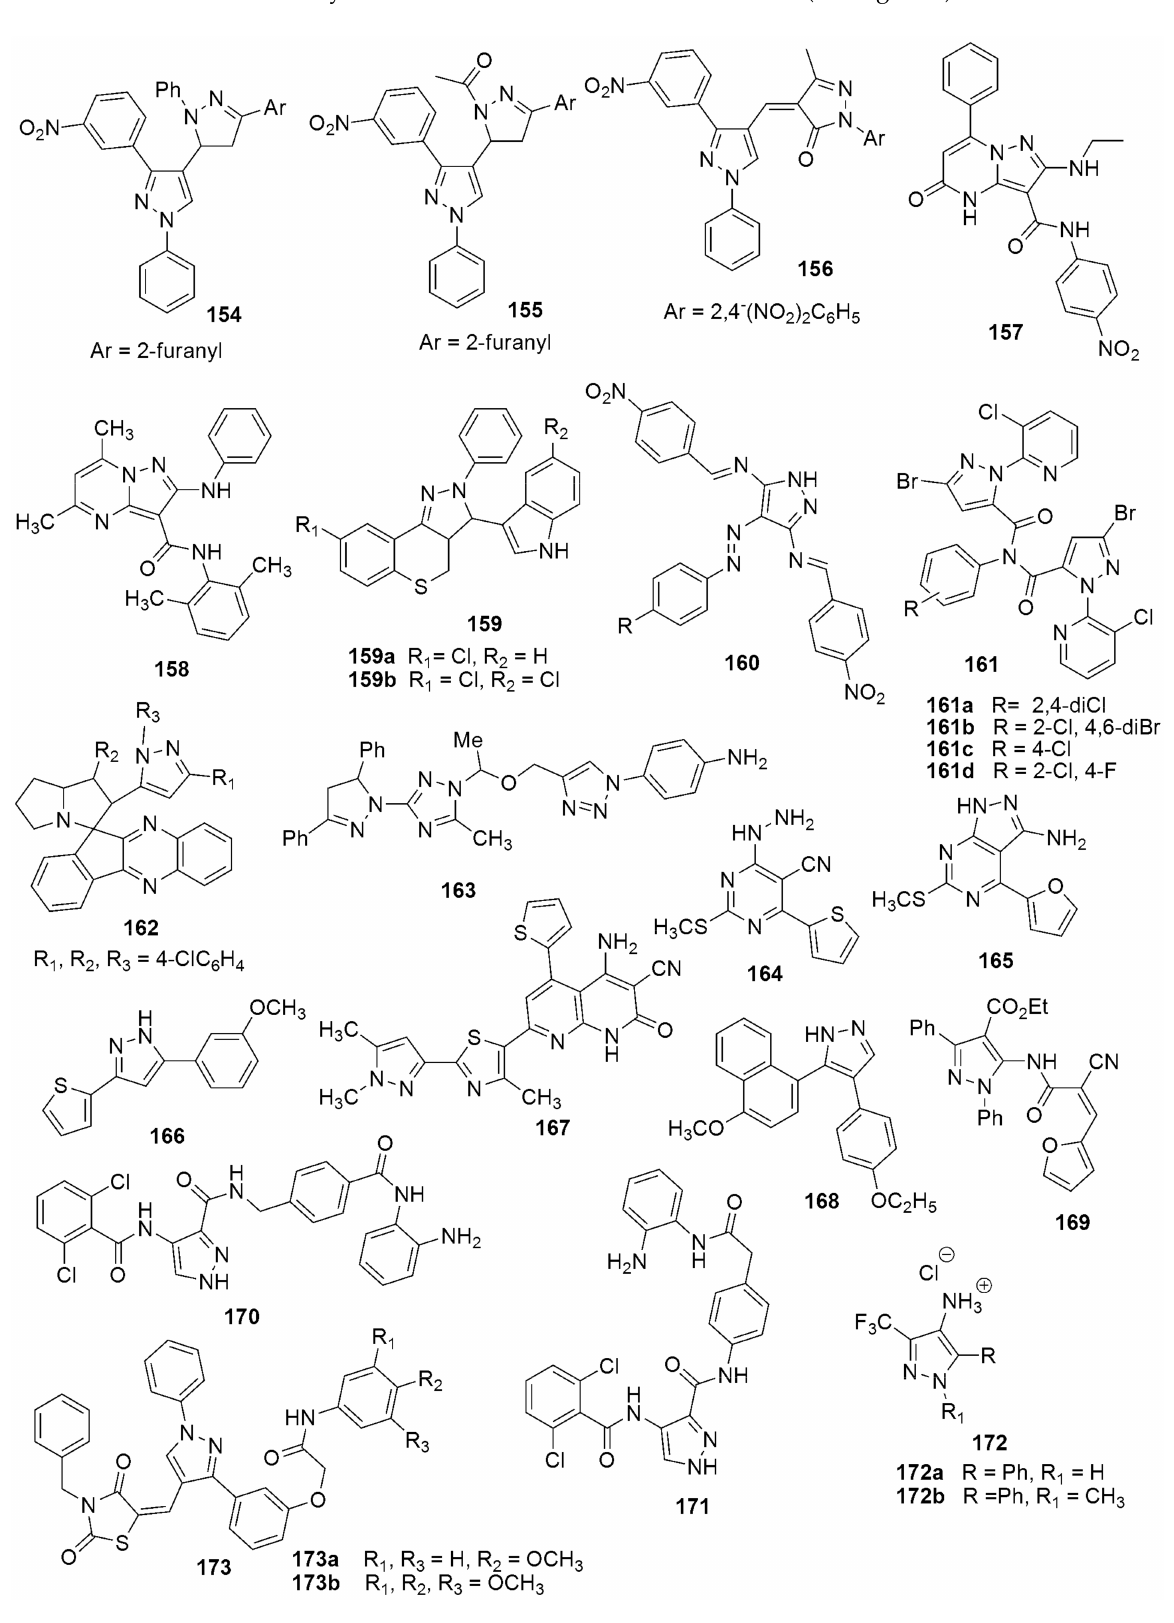
Figure 7. Structures of pyrazole derivatives with anticancer